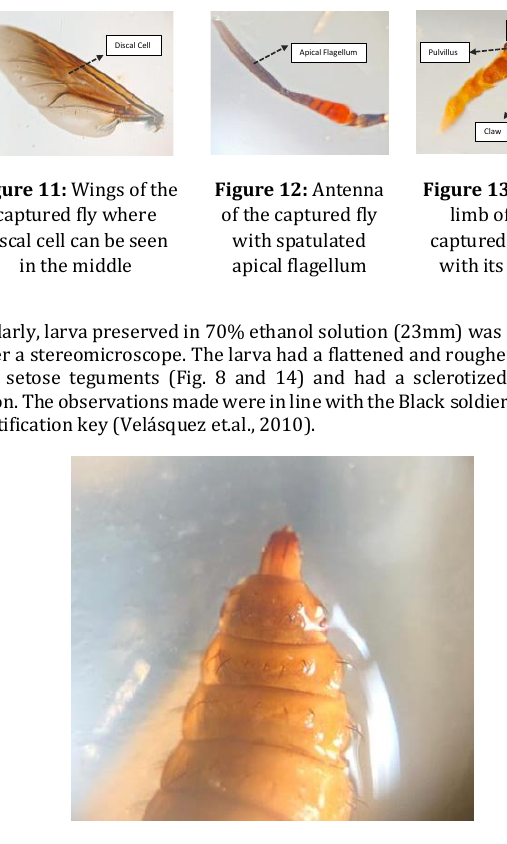
Figure 14: Cephalic region of the captured larva observed under